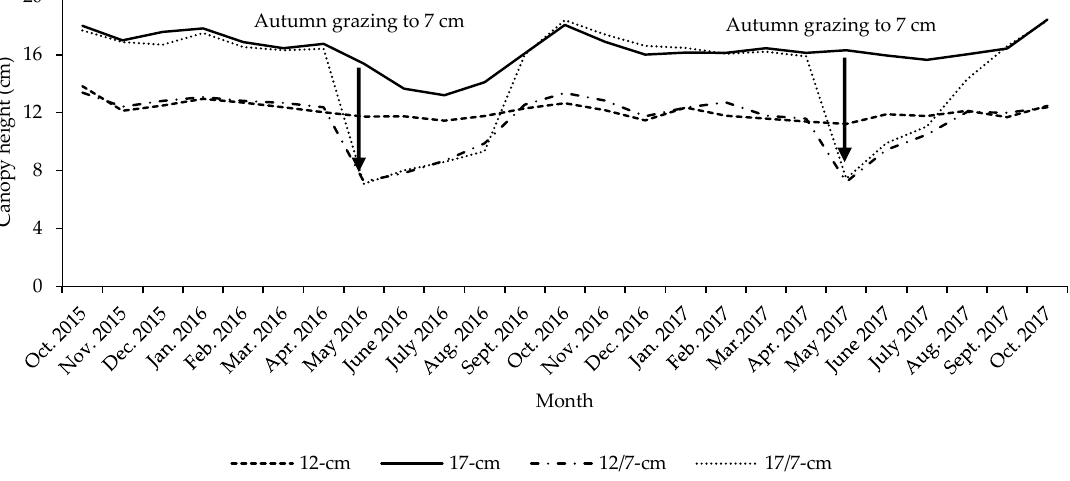
Figure 1. Canopy height of pastures composed of kikuyu-grass and tall fescue during the years 2015, 2016, and 2017. Treatments 12 cm and 17 cm represent canopy heights maintained uninterrupted throughout the experiment; treatments 12/7 cm and 17/7 cm represent the canopy heights with autumn grazing to 7 cm height in May.